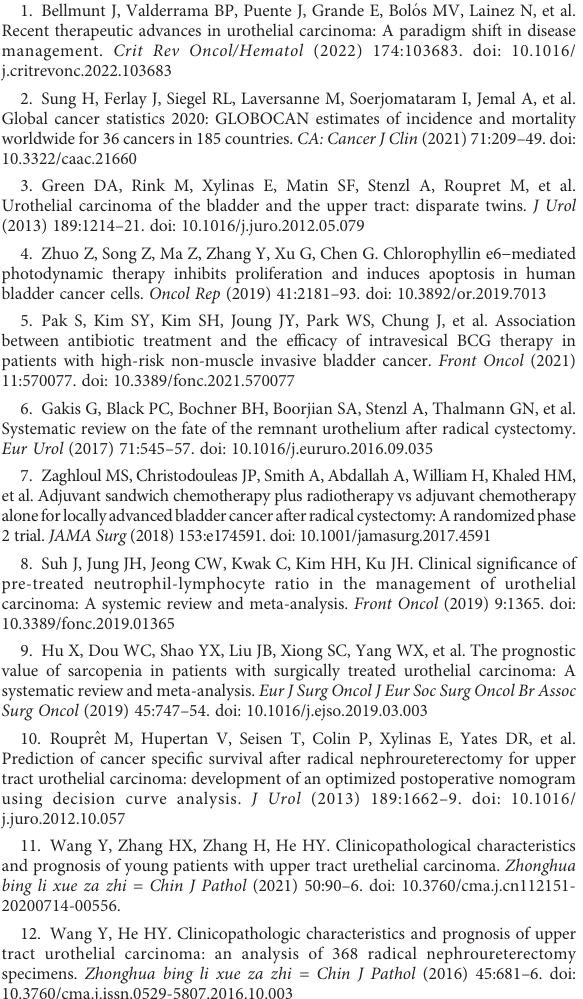
SUPPLEMENTARY FIGURE 1 Forest plot for sensitivity analysis. (A) overall survival and (B) cancer- speci fi c survival. SUPPLEMENTARY FIGURE 2 Begg ’ s test for (A) overall survival and (B) cancer-speci fi c survival; Trim and fi ll method for (C) overall survival and (D) cancer-speci fi c